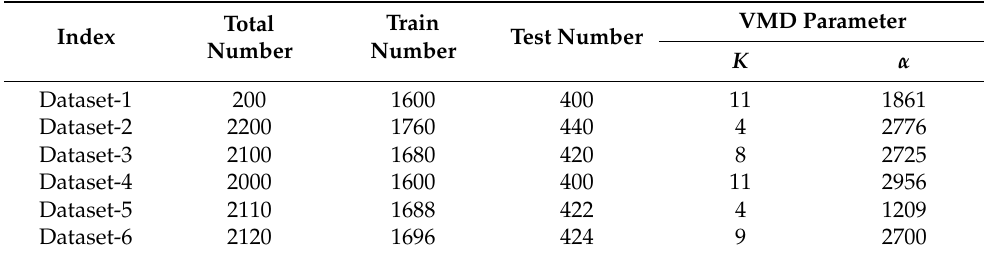
Table 1. Datasets and VMD decomposition